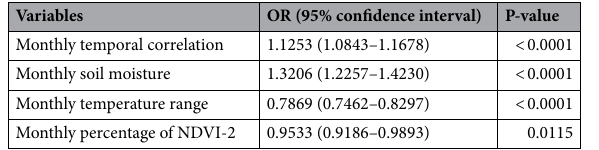
Table 3. Results of the final generalized linear mixed model for monthly reported cases. OR odds